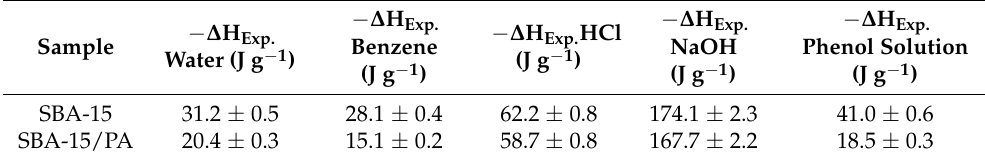
Table 3. Enthalpies of immersion for SBA-15 and its modification in water, benzene, and solutions of HCl, NaOH, and